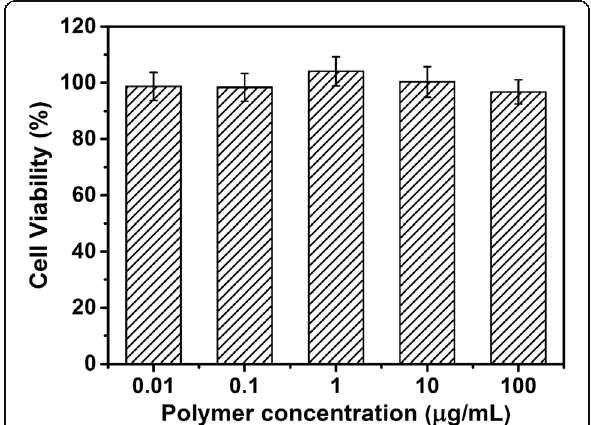
Fig. 8 Cell viability of HEK-293 cells exposed to blank PDA@PMAA-1 nanoparticles for 24